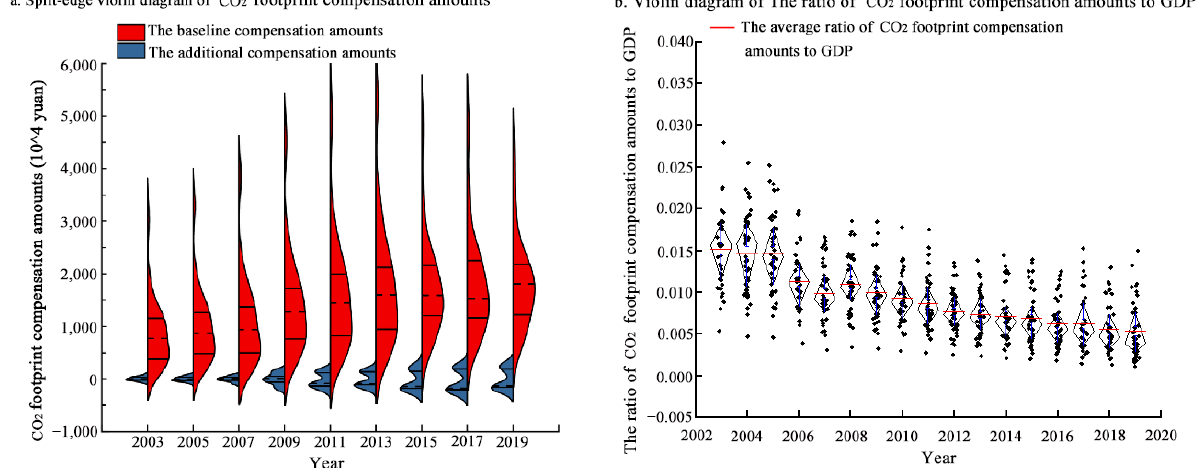
Figure 8.Figure 8. CO 2 footprint compensation amounts and its ratio to local GDP in the